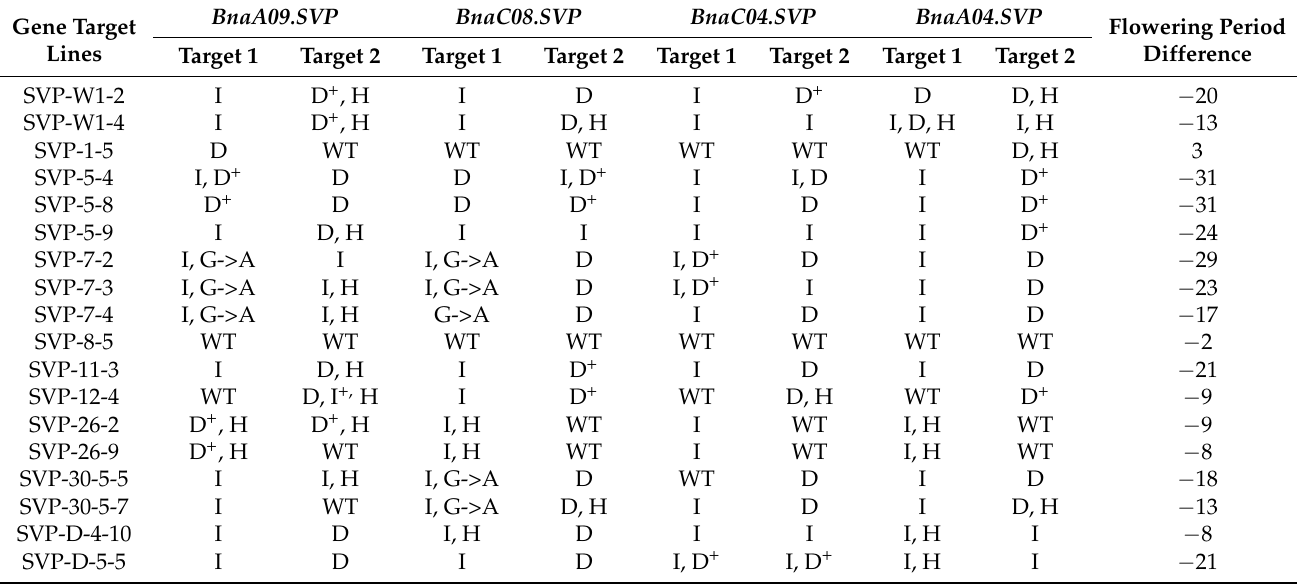
Table 1. Analysis of the mutation types and flowering period differences for the T1-generation svp mutants.